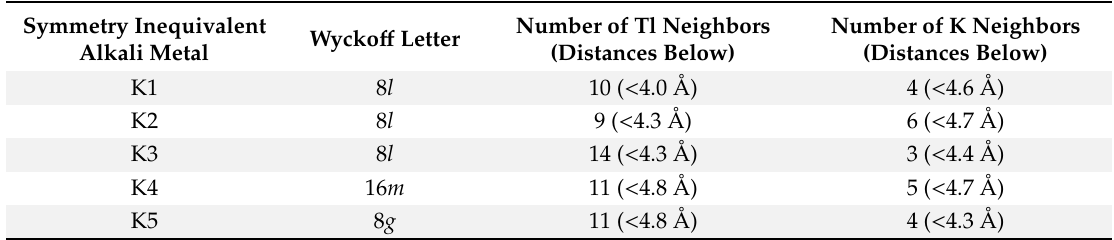
Table 1. Surrounding atoms of the symmetry inequivalent potassium positions in K 6 Tl 17 (space group Cccm